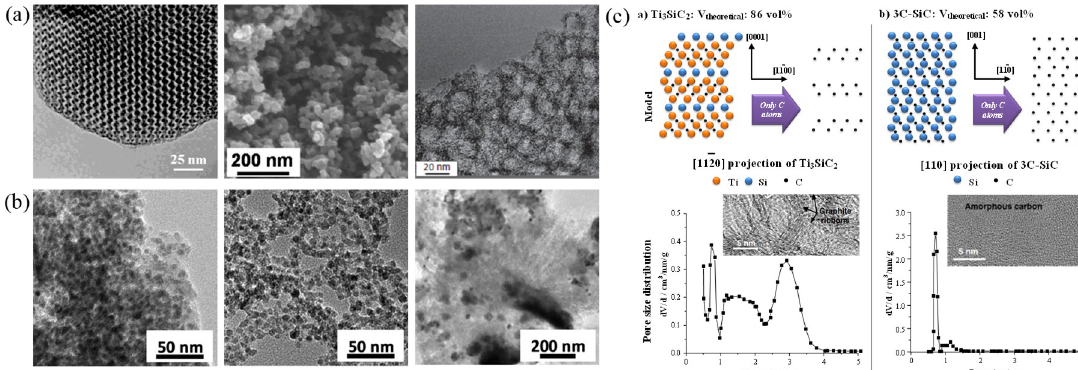
Figure 3. ( a ) Transmission or scanning electron microscopy (TEM and SEM) images of an ordered mesoporouscarbon (left) [44], a carbon aerogel (middle) [47], and a mesoporous carbon foam (right) [49]; ( b ) TEM images of iron/carbon materials derived from Fe-metal-organic framework (Fe-MOF) precursors with different porosity (left: MOF xerogel; middle: MOF aerogel; right: microporous MOF) [57]; ( c ) Schematic of the atomic structure of Ti 3 SiC 2 (left) and 3C-SiC (right) and the corresponding carbide-derived carbon (CDC) structures with TEM images and pore size distributions after halogen treatment [60]. ( a ) reproduced from [44], with permission from Wiley, 2001, from [47], with permission from RSC Publishing, 2014, and from [49], with permission from Wiley, 2013; ( b ) reproduced from [57], with permission from RSC Publishing, 2017; ( c ) reproduced from [60], with permission from Wiley, 2011.